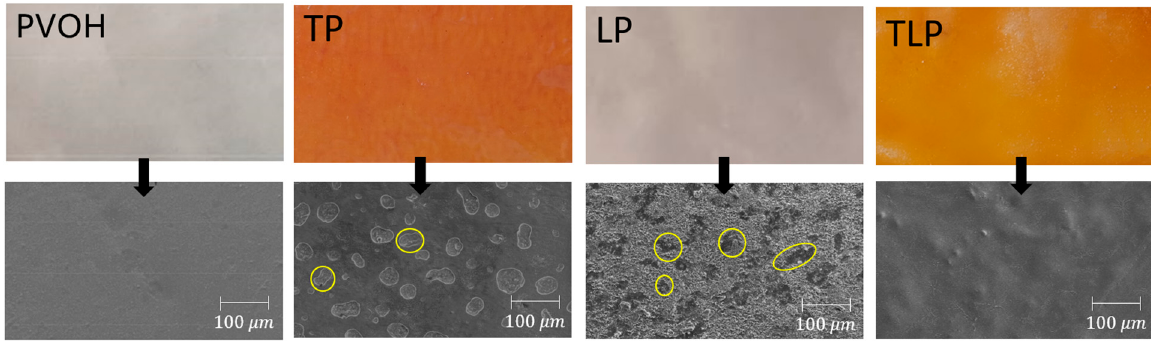
Figure 3. SEM micrographs of the various films.